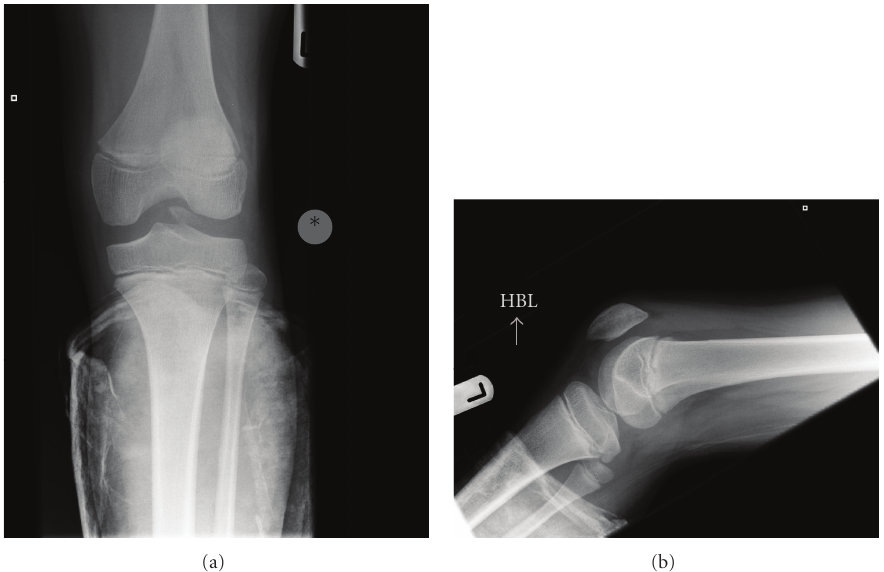
Figure 1: (a) Anteroposterior and (b) lateral views of the patient’s knee depicting an intra-articular fracture fragment.